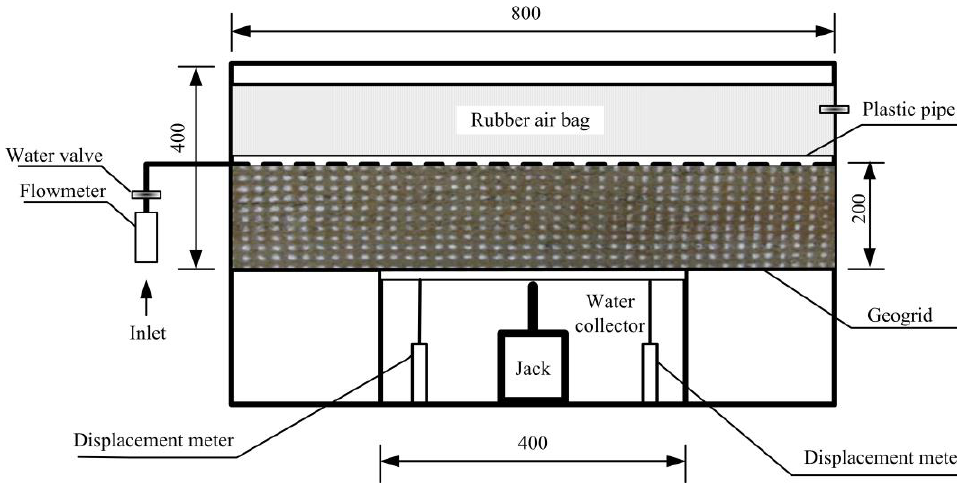
Figure 3. Sketch of apparatus (all dimensions are in mm).